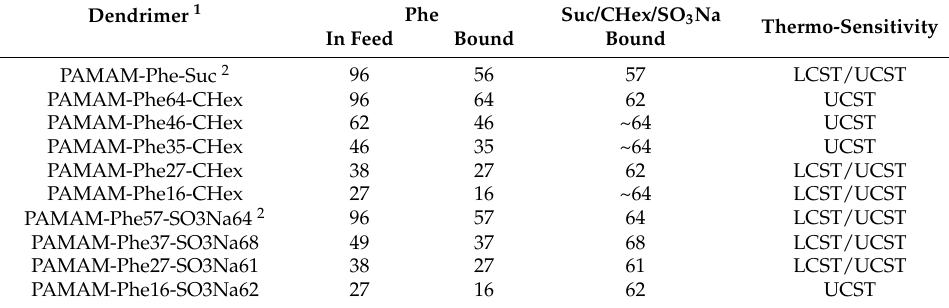
Table 1. List of synthesized dendrimers in this